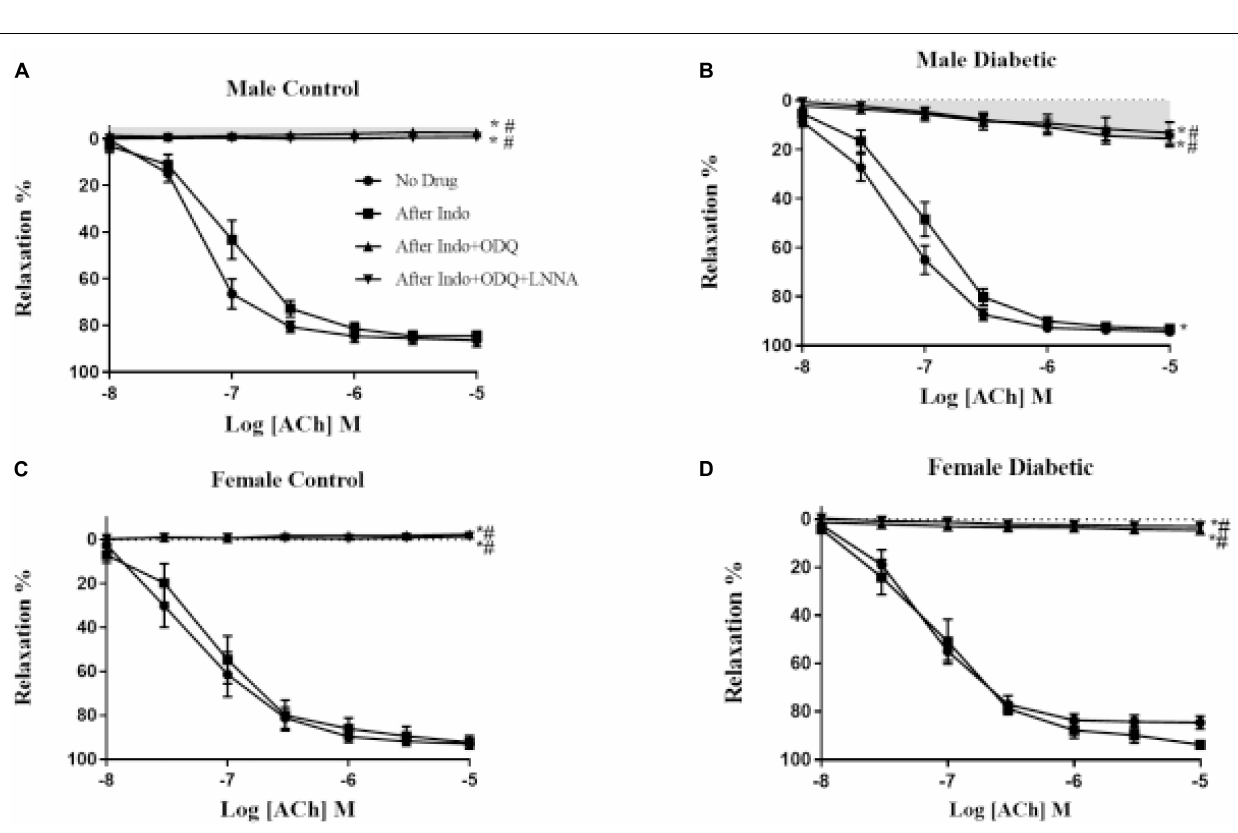
Frontiers in Physiology |